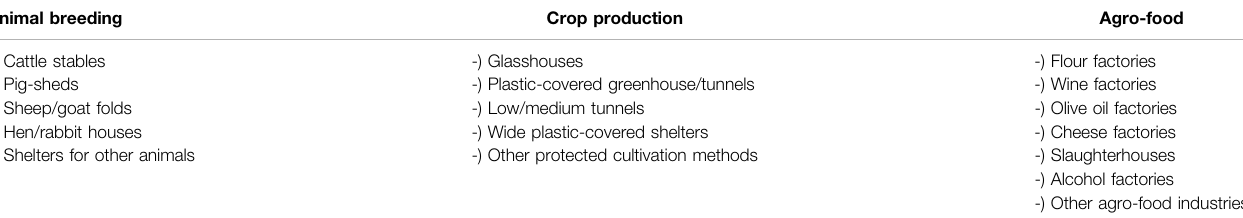
TABLE 1 | Main categories of farm